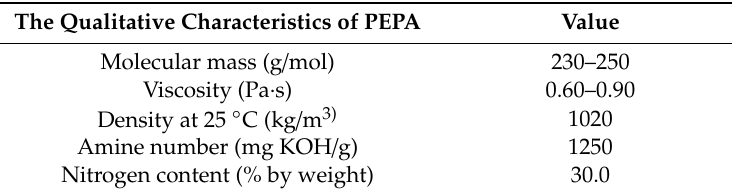
Table 3. Properties of TCEP .